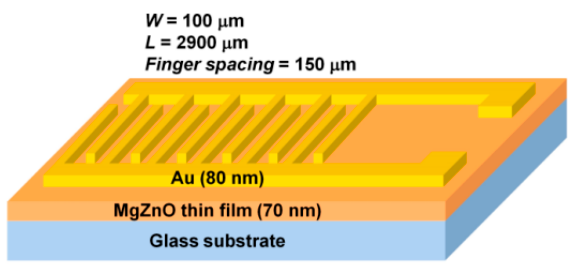
Figure 1. Schematic of designed Au − Mg x Zn 1 − x O photodetector on glass substrate with metal − semiconductor − metal (MSM)